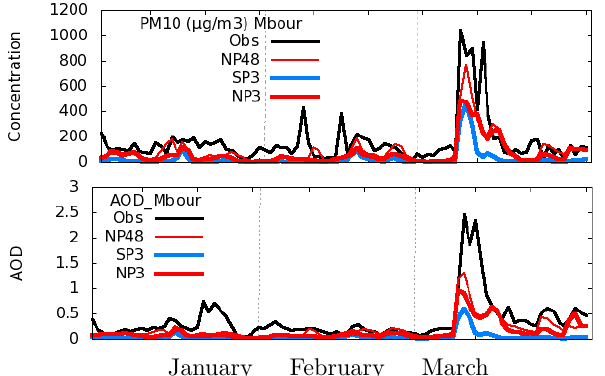
Figure 5. Time evolution over winter 2006 of the daily mean PM 10 concentration (top, in µgkg − 1 ) and AOD for the M’bour station for simulations SP3 (blue), NP3 (thick red line) and NP48 (thin red line) and for observations